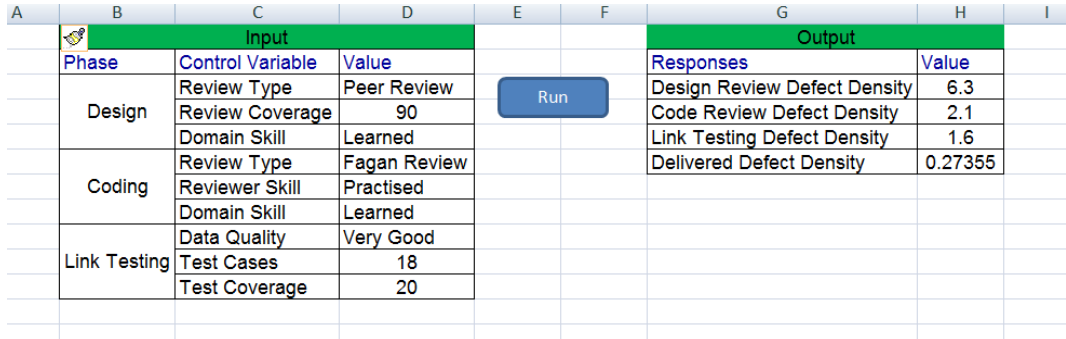
Fig. 9. MS Excel template for the